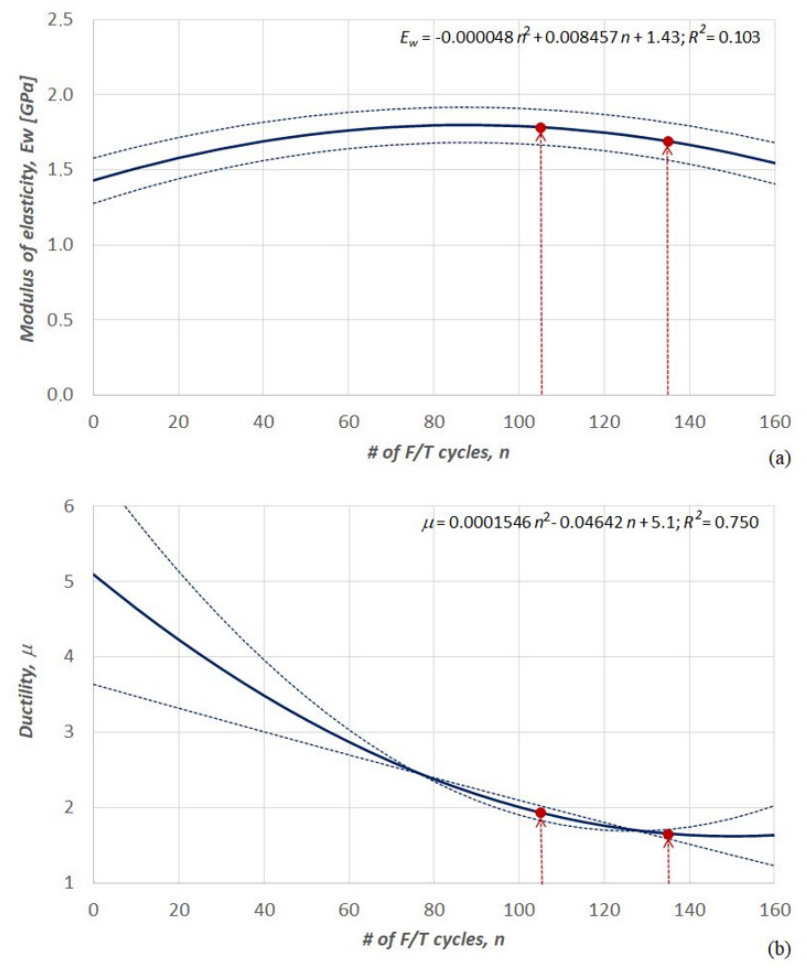
Figure 7. Predicted values for Young’s modulus ( a ) and ductility ( b ) after 20 years for an existing masonry brick building in a hypothetical scenario. The graphs from Figures 2 and 3 were applied.